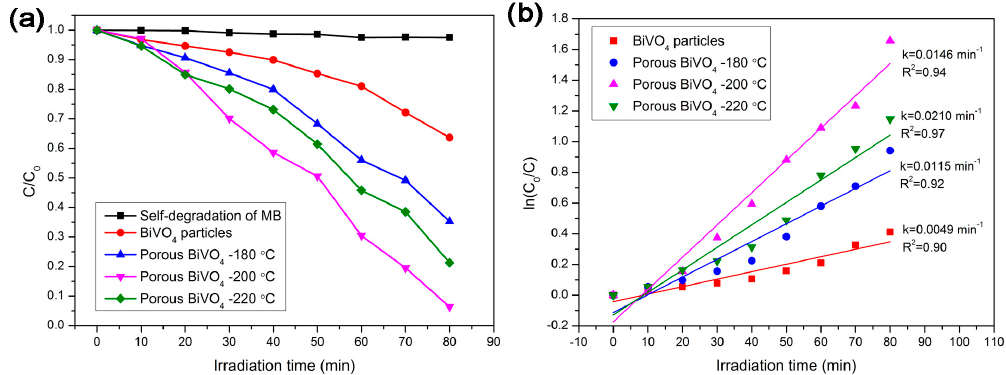
Figure 5. Photocatalytic degradation of MB solution ( a ) and plots of ln(C 0 /C) versus irradiation time ( b ) in the presence of as-prepared samples.